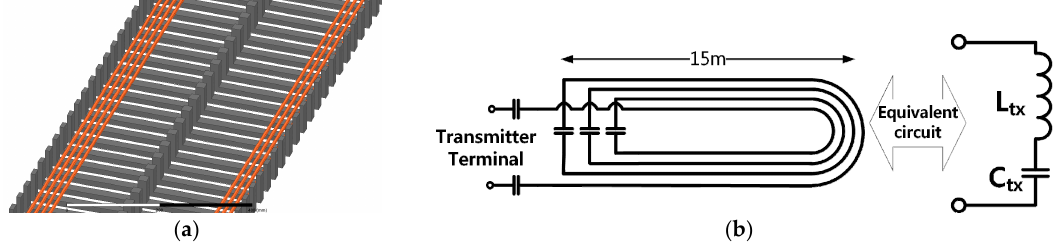
Figure 4. Designed transmitter coil and its tuning method for voltage suppression: ( a ) a schematic of the designed 4-turn transmitter track; ( b ) distributed tuning method of the transmitter coil.